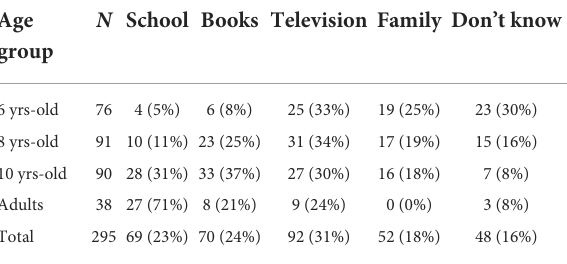
TABLE 5 Number (and percentage) of answers corresponding to each source of knowledge as a function of age. Sources of